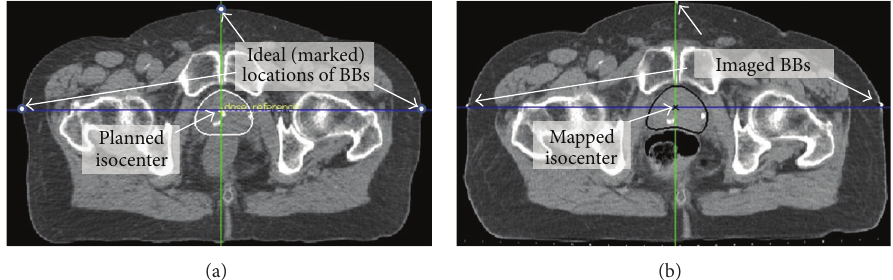
Figure 2: (a) Axial slice from the pCT showing planned isocenter inside the prostate (white contour) and the marked locations of BBs. (b) Corresponding slice from the tCT showing the autosegmented prostate (black), nonrigidly mapped isocenter, and imaged